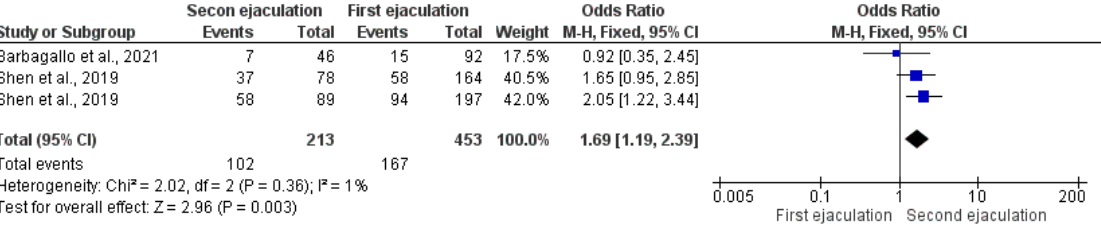
Figure 5. Forest plot showing the effects of a very short abstinence period on the live birth